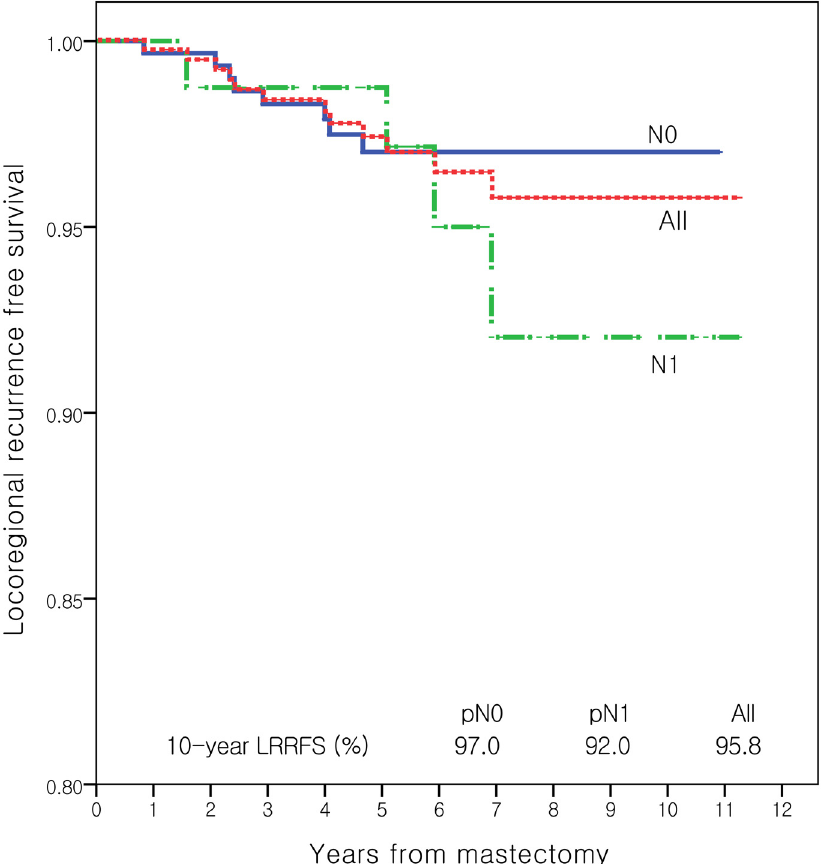
Fig 1. Kaplan-Meier curves for locoregional recurrence free survival (LRRFS) according to the pathologic nodal stage.